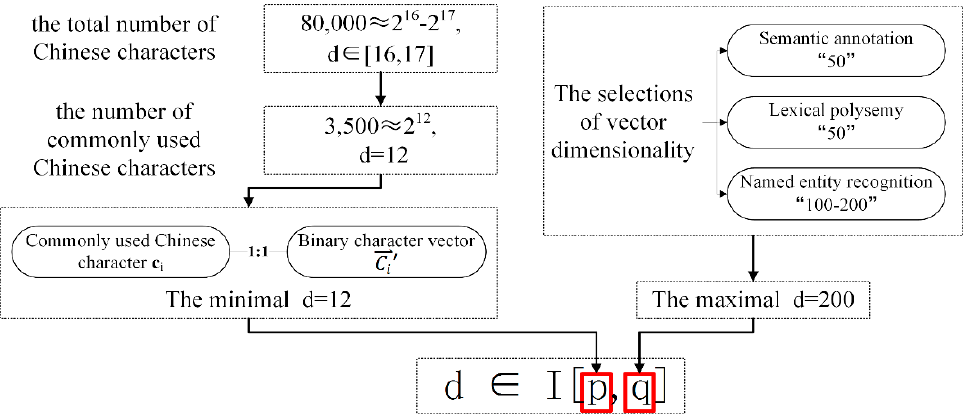
Figure 3. The selection of the dimensionality interval boundaries.